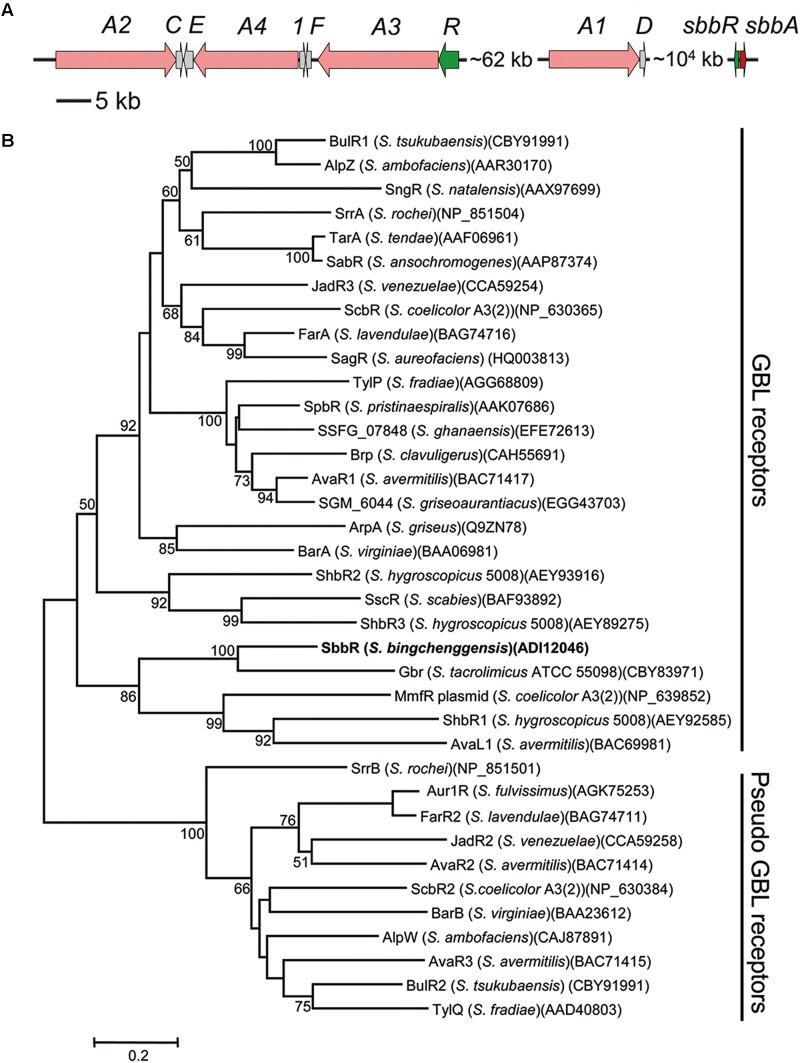
Bioinformatic analysis of SbbR in S. bingchenggensis BC04. (A) Schematic representation of the relative positions of sbbR, sbbA, and the mil cluster. Each arrow indicates a separate open reading frame (ORF) and orientation of transcription. (B) Phylogenetic analyses of SbbR and its homologs. SbbR of S. bingchenggensis BC04 is highlighted in bold. The CLUSTALW program was used for performing sequence alignment. The phylogenetic tree was constructed by applying the neighbor-joining algorithm. Bootstrap values >50% (based on 1000 replications) are shown at branch points. Bar, 0.02 substitutions per amino acid position for the phylogenetic tree of SbbR.